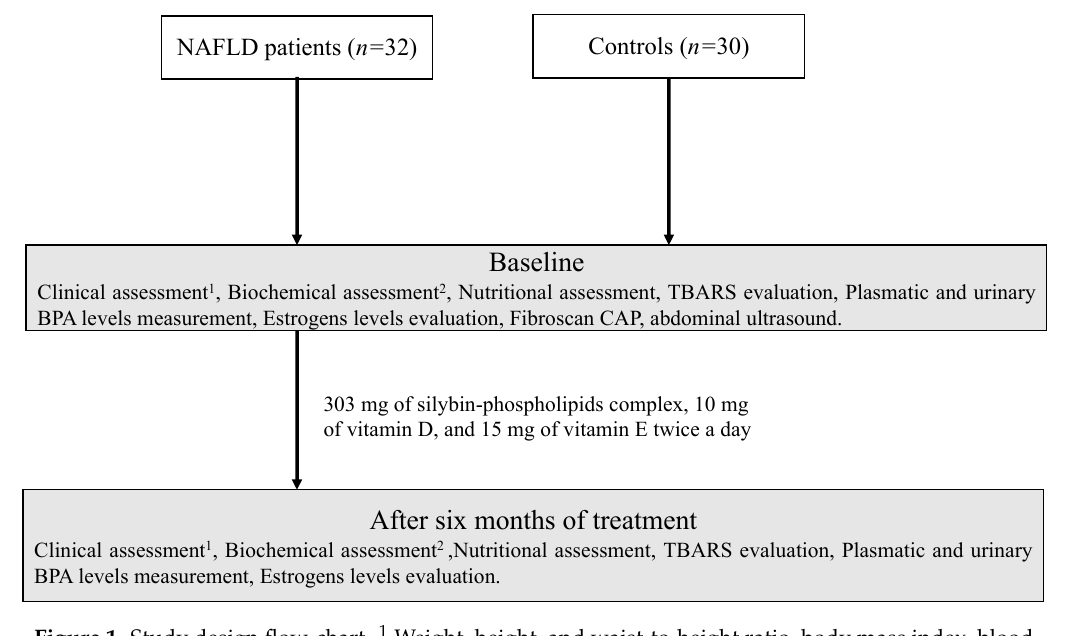
Figure 1. Study design flow-chart. 1 Weight, height, and waist-to-height ratio, body mass index, blood pressure measurement; 2 Blood glucose and insulin, homeostasis model assessment, aspartate and alanine aminotransferases, gamma-glutamyl transpeptidase, blood count, C-reactive protein, tumor necrosis factor alpha. NAFLD: non-alcoholic fatty liver disease; TBARS: thiobarbituric acid reactive substances; BPA: bisphenol A; CAP: controlled attenuation parameter.